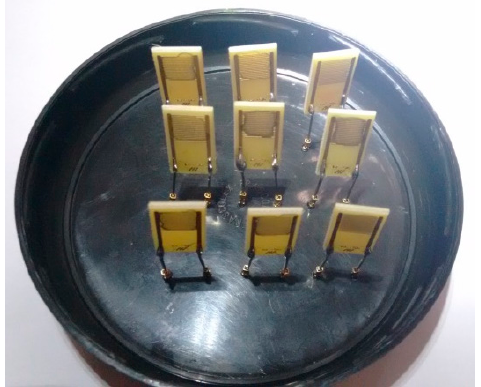
Figure 3. Array of sensors placed in the cap.